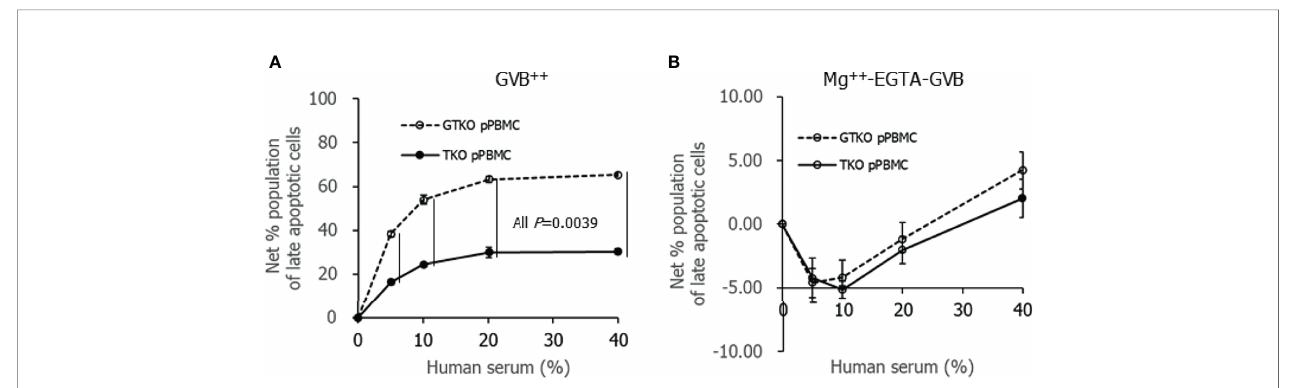
FIGURE 4 | Apoptotic change of porcine cells after incubating in Ca ++ enriched gelatin veronal buffer ( GVB ++ , A) or Mg ++ -EGTA-GVB (B) with various concentrations of human serum. After incubation, the cells were stained with fl uorescein Annexin V and propidium iodine, and the percent population of late apoptotic cells were analyzed using fl ow cytometry. A net percent population of late apoptotic cells of the sample was calculated by subtracting their percent population in the sample without serum.